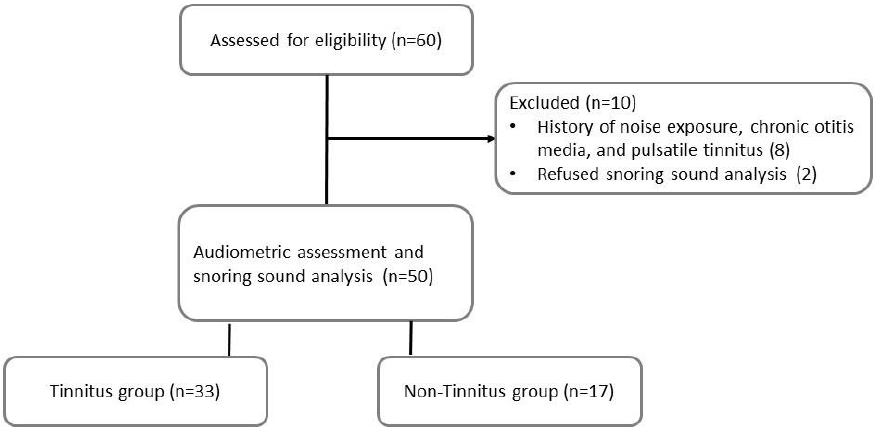
Figure 1. Flowchart of the study .